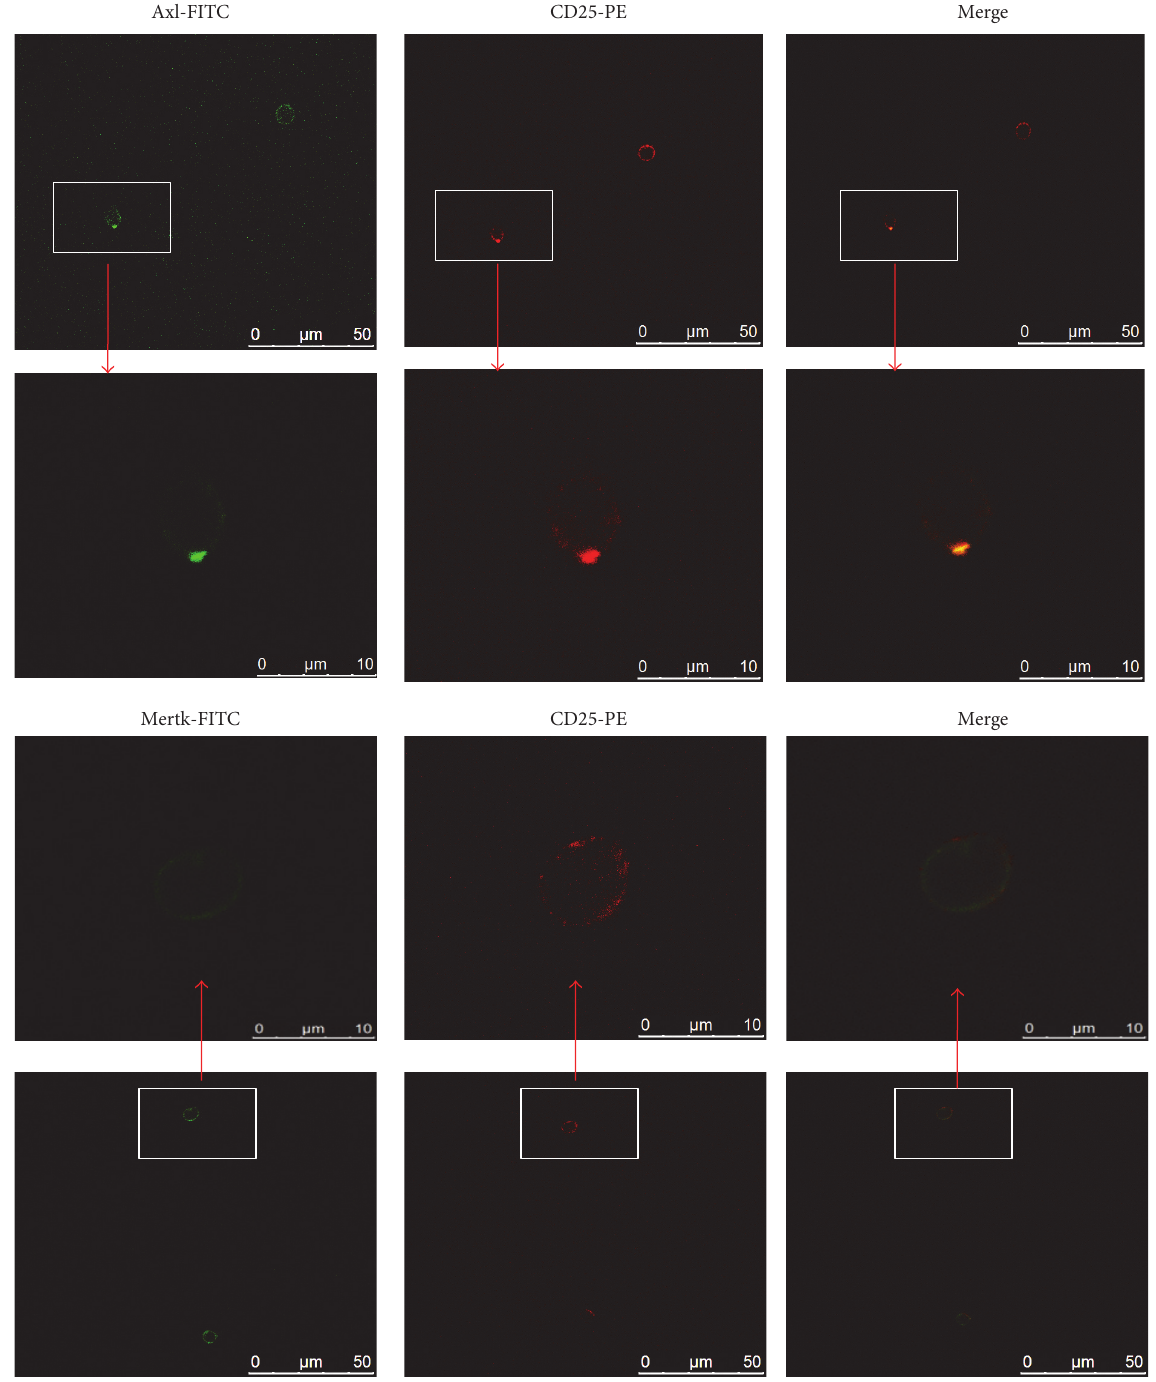
Figure 2: Immunofluorescence detection of TAM receptors. CD4 + CD25 + Tregs were incubated with anti-Axl (10 𝜇 g/ml) and anti-Mertk (10 𝜇 g/ml) monoclonal Ab, respectively, followed by FITC-labeled goat anti-rat IgG as the secondary Ab (1: 30). The cells were analyzed by fluorescent confocal microscopy. Representative photomicrographs show that FITC-positive cells (green) were detected among PE-positive CD4 + CD25 + Tregs (red). Those double-stained cells are shown in